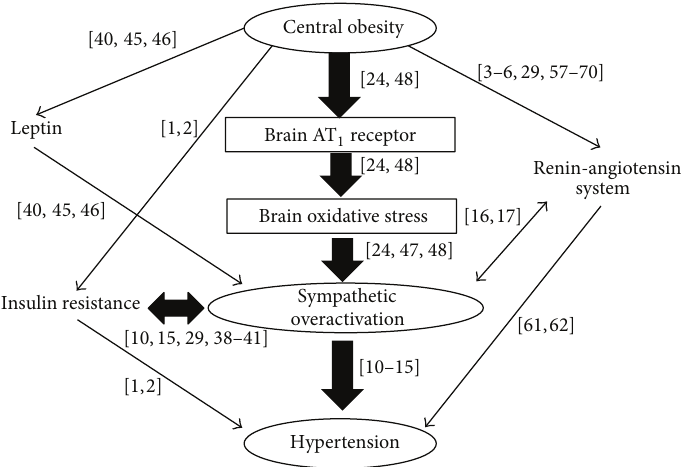
Figure 1: A schema presenting our concept in the regulation of sympathetic nervous system mediated by brain renin-angiotensin system in the metabolic syndrome. The numbers on the different arrows are the references from the